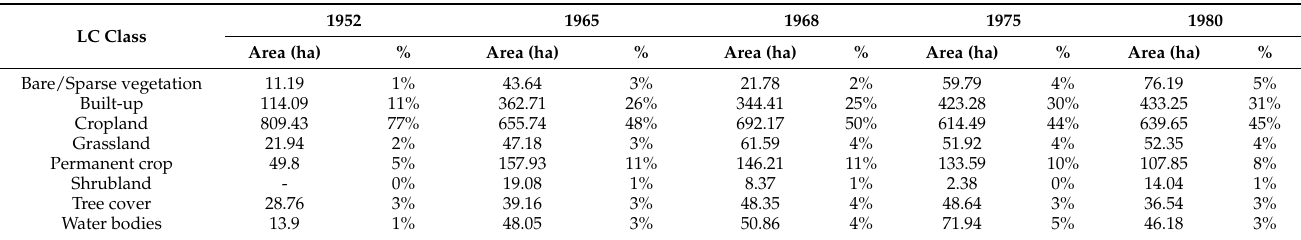
Table 10. Temporal evolution of the LULC classes in Stamboliyski from 1952 to 1980 (in absolute numbers and